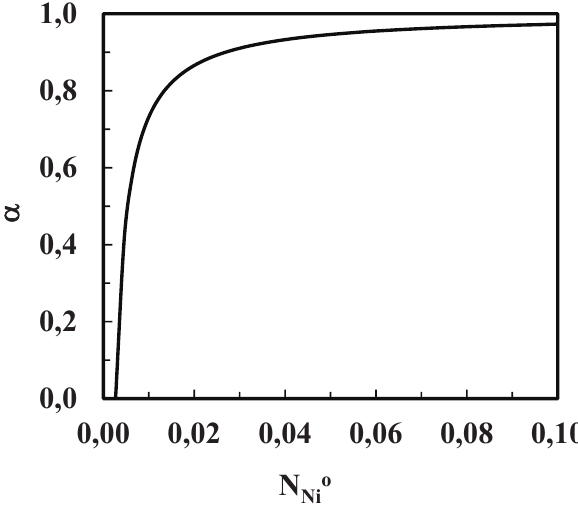
Figure 8. Plot of the parameter ˛ as a function of the Ni content for the oxidation of Cu-Ni alloys at 800 °C in 1 atm O 2